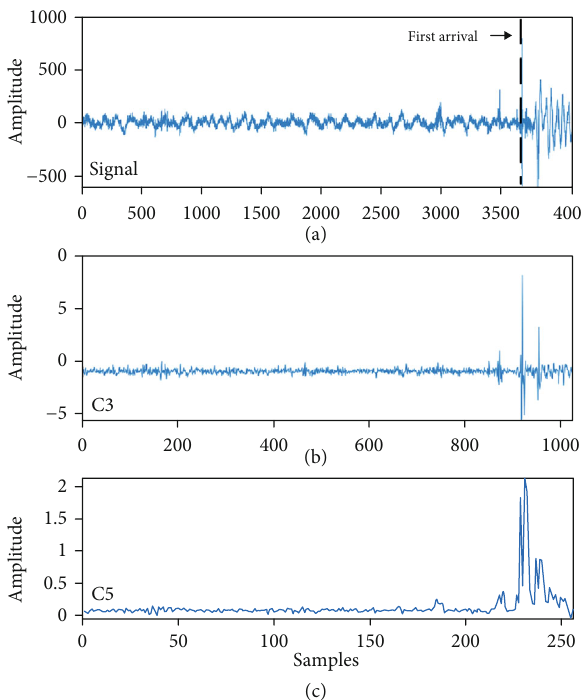
Figure 18: The fi rst trace signal of the actual microseismic record pro fi le shown in Figure 17 and its intermediate features extracted by the UNet++. (a) The fi rst trace signal of the actual microseismic record pro fi le shown in Figure 17. (b) Intermediate features of the signal extracted by C3 layer. (c) Intermediate features of the signal extracted by C5 layer.